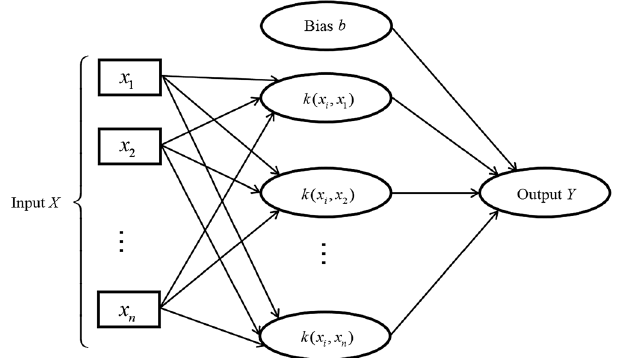
Figure 4. Support vector machine